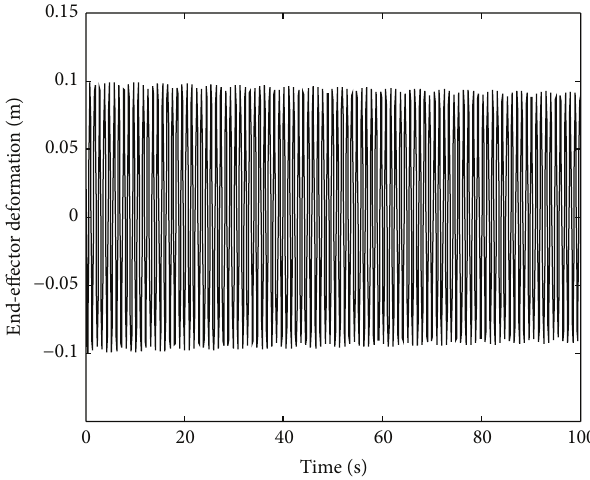
Figure 2: Response of the uncontrolled fixed flexible